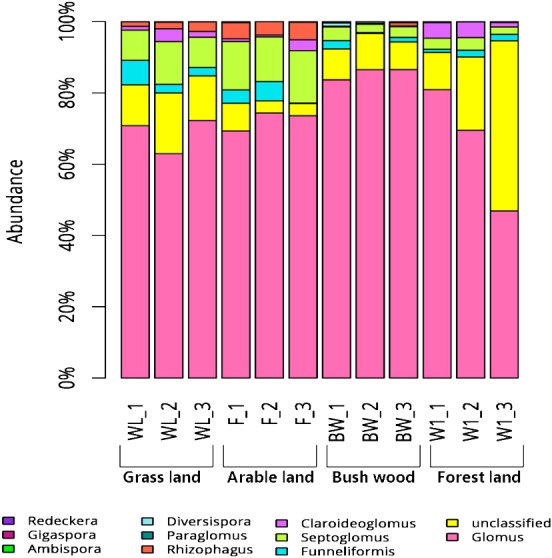
Abundance percentages of AMF genera for all soil samples.